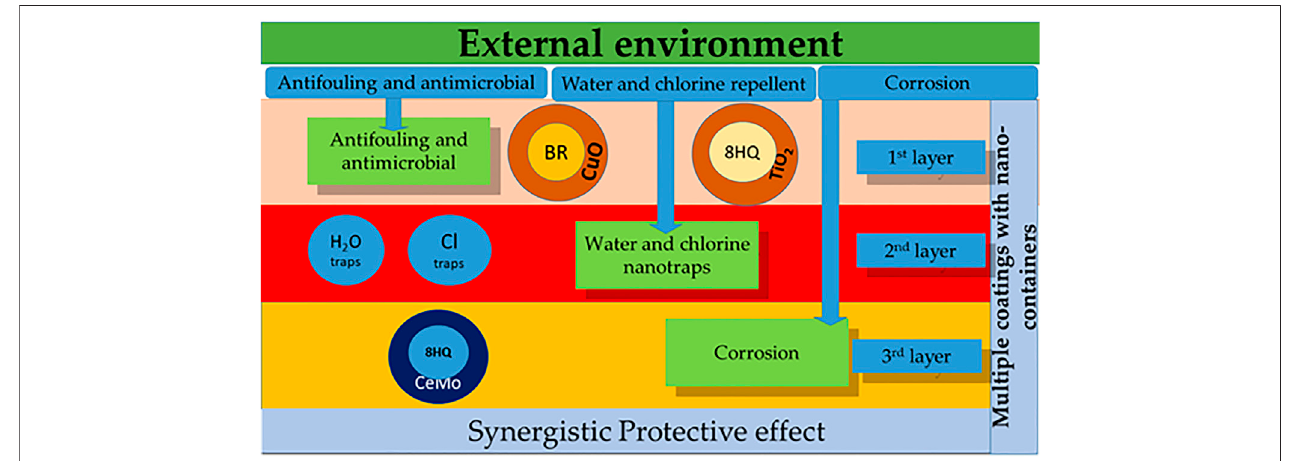
FIGURE 1 | Multilevel protection of metals via nano/microcontainers. BR, bromosphaerol; 8-HQ, 8-hydroxyquinoline; CeMo, cerium/molybdenum oxide; CuO, copper oxide.